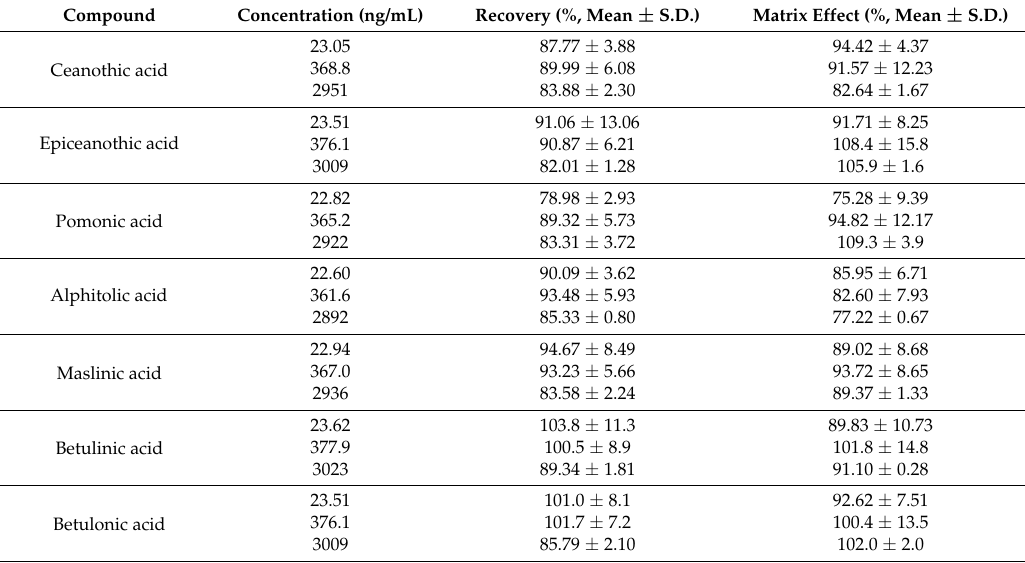
Table 3. Recoveries and matrix effects of the seven compounds in rat plasma.